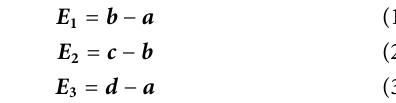
Frontiers in Mechanical Engineering |